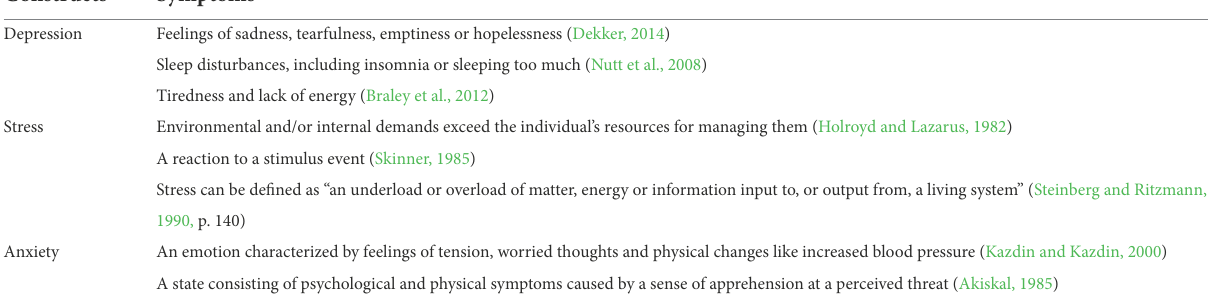
TABLE 5 Evidence-based definitions and symptoms of depression, stress and anxiety. Constructs Symptoms